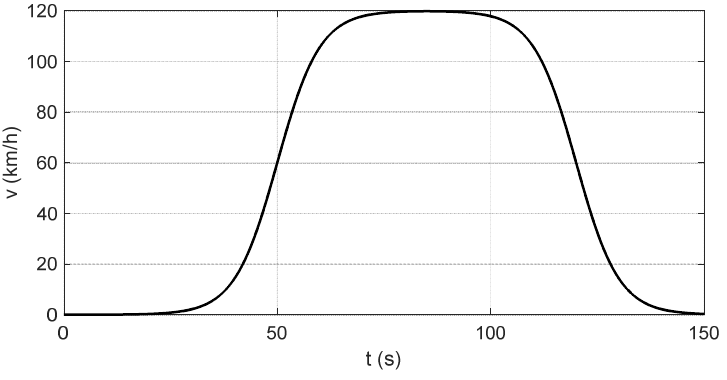
Figure 12. Designed vehicle speed profile.